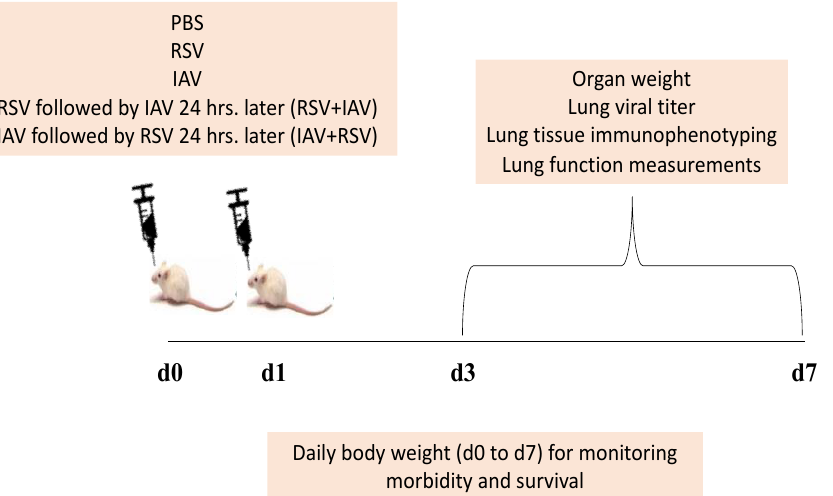
Figure 1. A schematic representation of the experimental strategy for the RSV and IAV co-infection model. Mice were intranasally infected with RSV A2, IAV PR8 or both, one after the other, after a 24 h interval (RSV+IAV or IAV+RSV). One group of mice was intranasally inoculated with PBS and served as the control group. All groups were monitored for up to 7 days (daily weight and survival); on selected days post-infection (d3 and d7), mice were sacrificed for experimental analyses that included organ (lung, spleen and thymus) weights, viral titers, immunophenotyping and lung function.